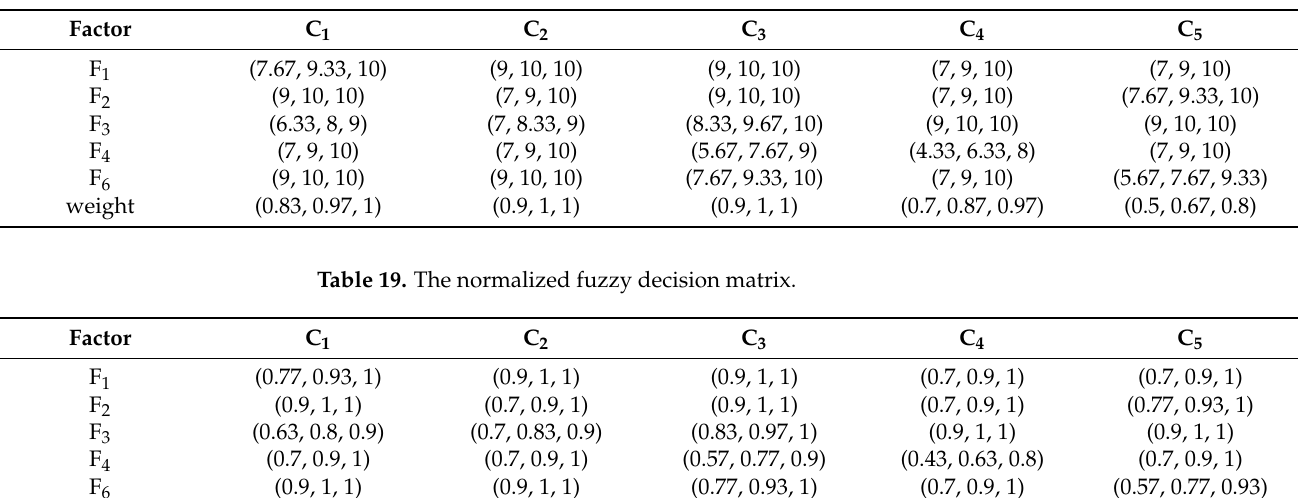
fuzzy decision matrix (Table 19) and weighted normalized matrix (Table 20) were computed. Table 18. The fuzzy decision matrix and fuzzy weights of five factors.